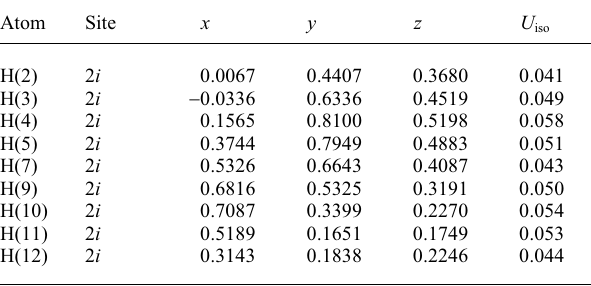
Table 2. Atomic coordinates and displacement parameters (in Å 2 )